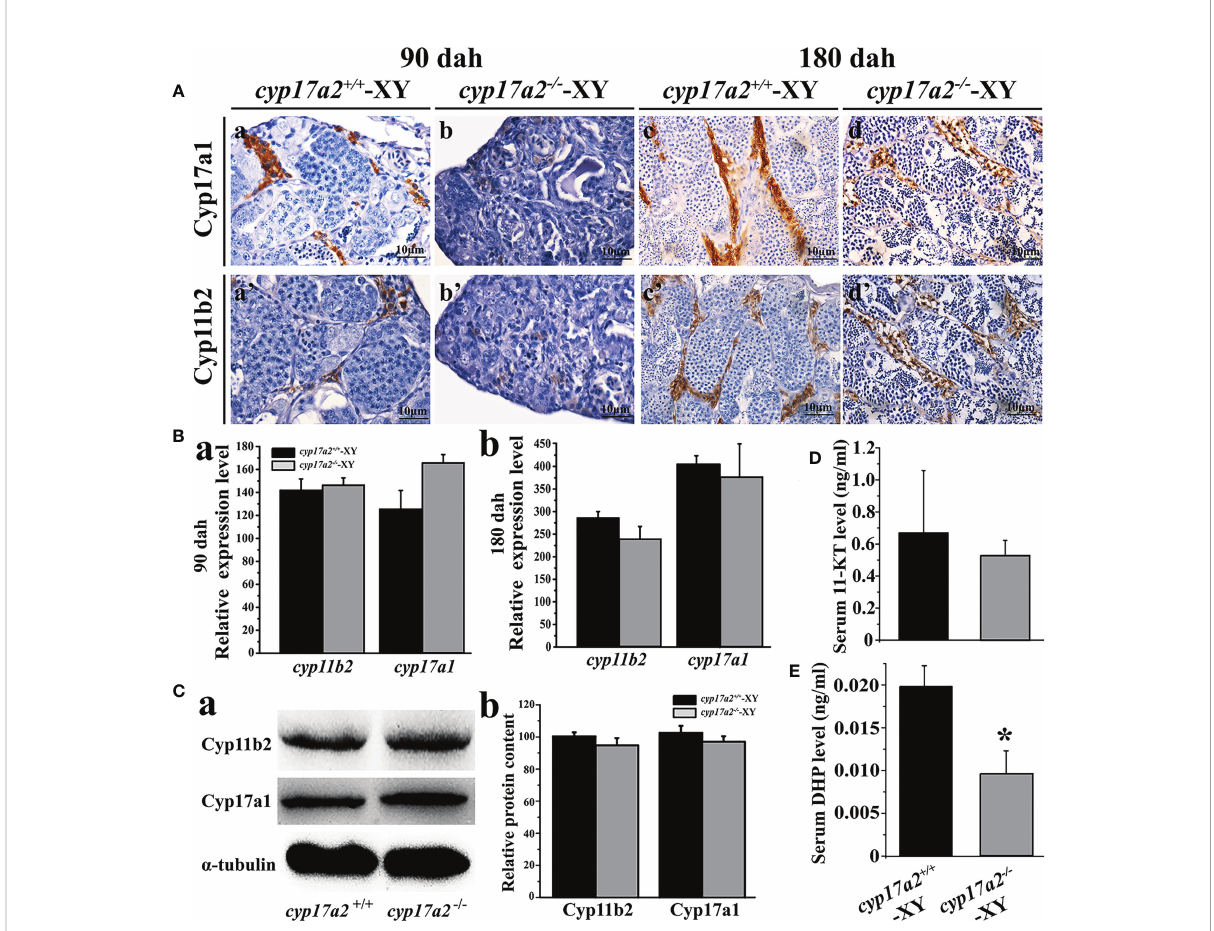
FIGURE 4 Effects of cyp17a2 de fi ciency on steroid production in testis of tilapia. (A) , Immunohistochemistry of Cyp17a1 (a-d) and Cyp11b2 (a ’ -d ’ ) in the testis of cyp17a2 +/+ and cyp17a2 -/- XY tilapia at 90 and 180 dah. (B) , Expression level of cyp11b2 and cyp17a1 in the testis of cyp17a2 +/+ (n=3) and cyp17a2 -/- (n=3) fi sh at 90 (a) and 180 dah (b) detected by qRT-PCR. b -actin was used as a reference gene to normalize the expression values. (C) , Expression of Cyp11b2 and Cyp17a1 analyzed by Western blotting (a) and quanti fi cation of protein level (b) in the testis of cyp17a2 +/+ and cyp17a2 -/- at 180 dah. (D, E) , Serum 11-KT and DHP level in cyp17a2 +/+ (n=5) and cyp17a2 -/- (n=5) fi sh measured using an EIA kit. The data are reported as the means±SD. Asterisk above the error bar indicate signi fi cant differences between groups tested by Student ’ s t -test (*, P<0.05).